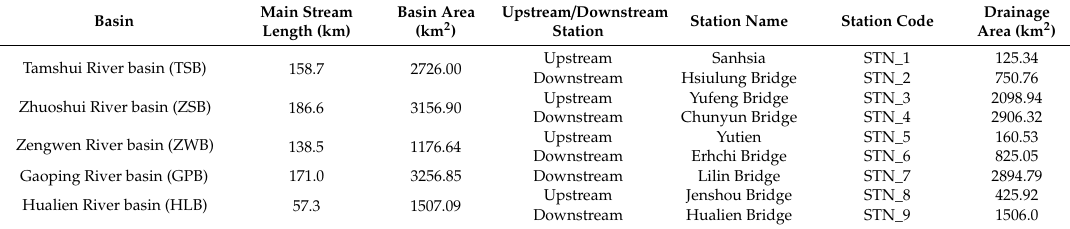
Table 2. Descriptive statistics of continuous water discharge for the five watersheds during